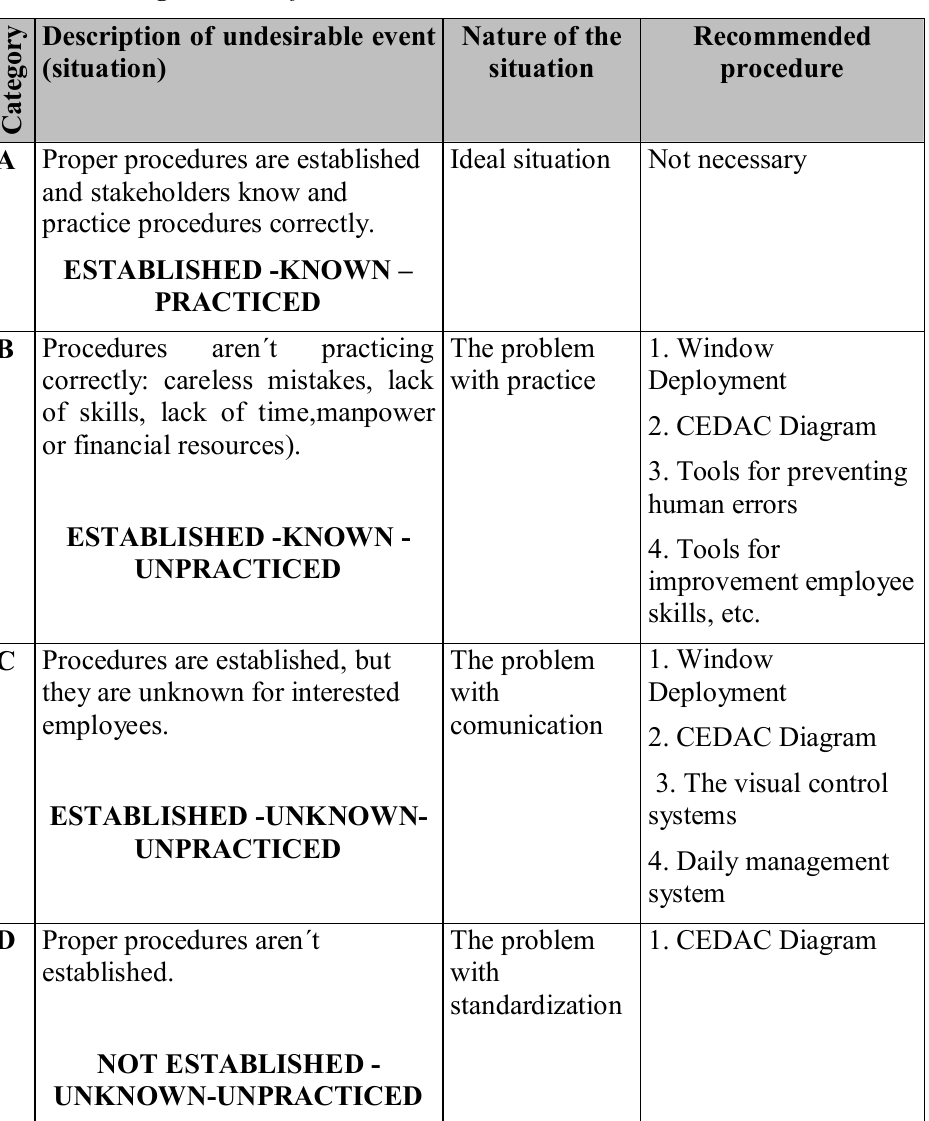
Table 4 - Categorization of situations Description of undesirable event y r go (situation) e e a t C